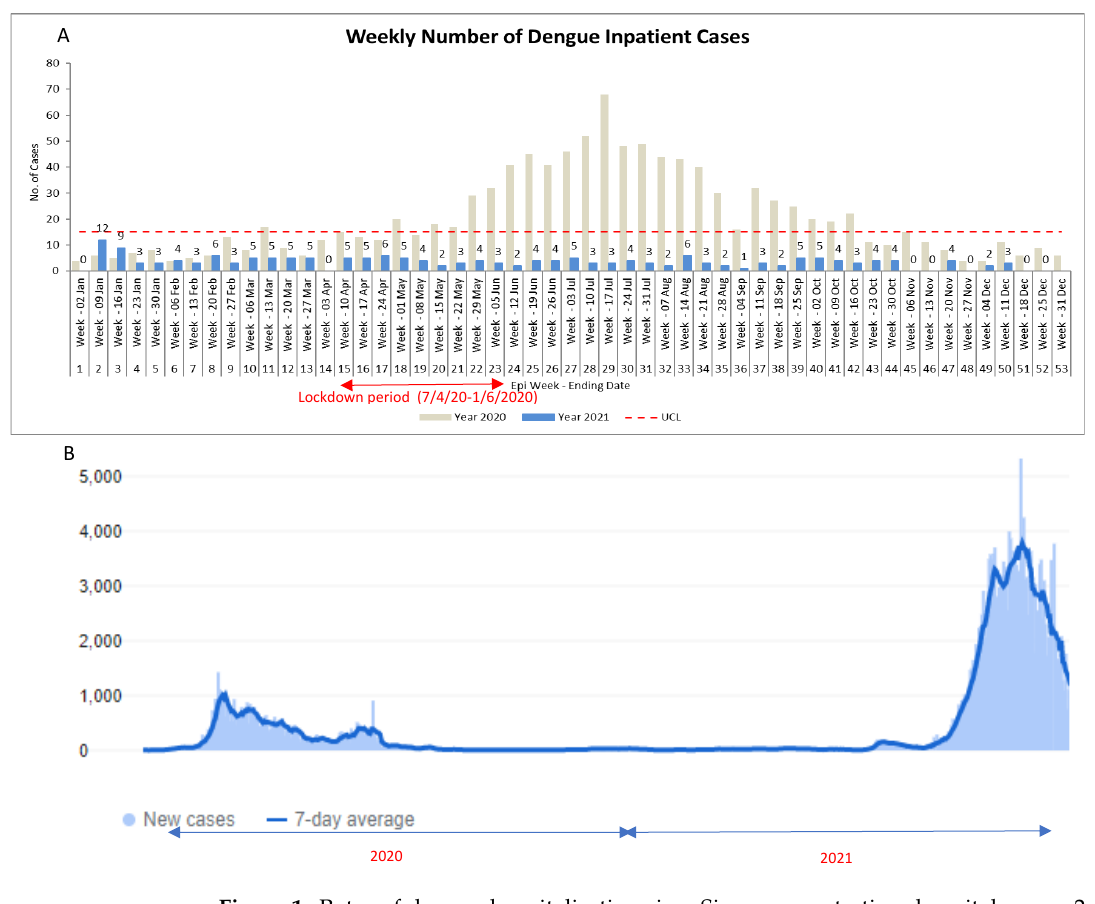
Figure 1. Rates of dengue hospitalisations in a Singaporean tertiary hospital over a 2-year study period during successive waves of community transmission in the COVID-19 pandemic. ( A ) Number